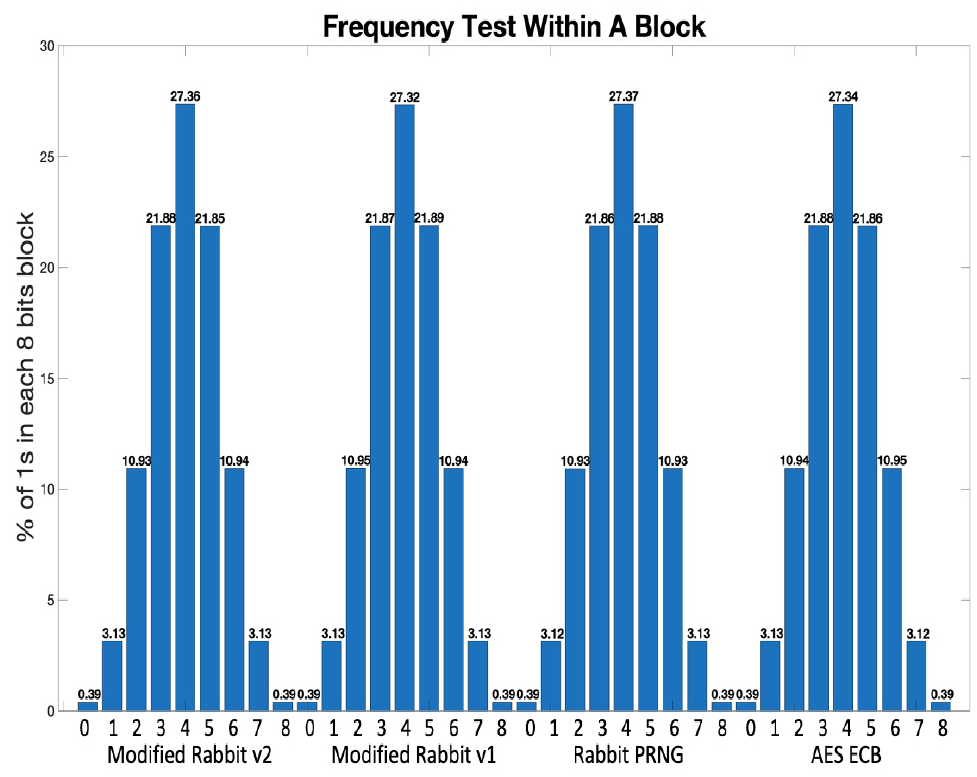
Figure 7. Frequency Test Within A Block: Modified Rabbit v2 vs Modified Rabbit v1 vs Rabbit vs AES